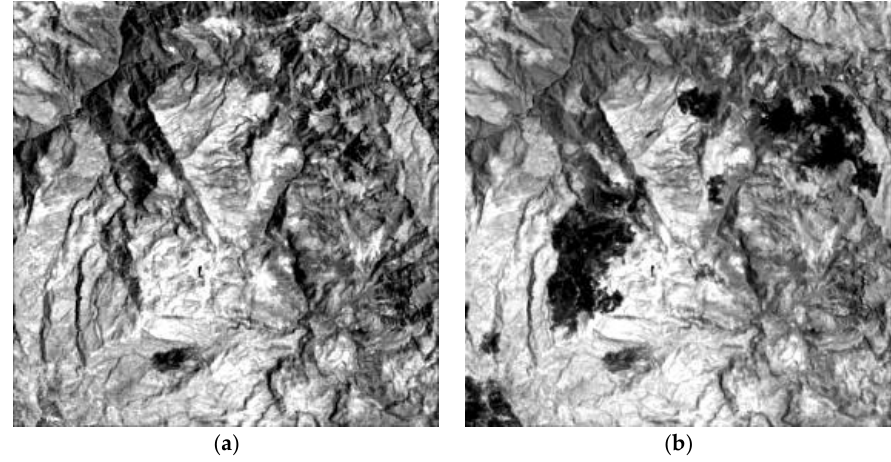
Figure 4. Mexico dataset. ( a ) Image acquired in April 2000. ( b ) Image acquired in May